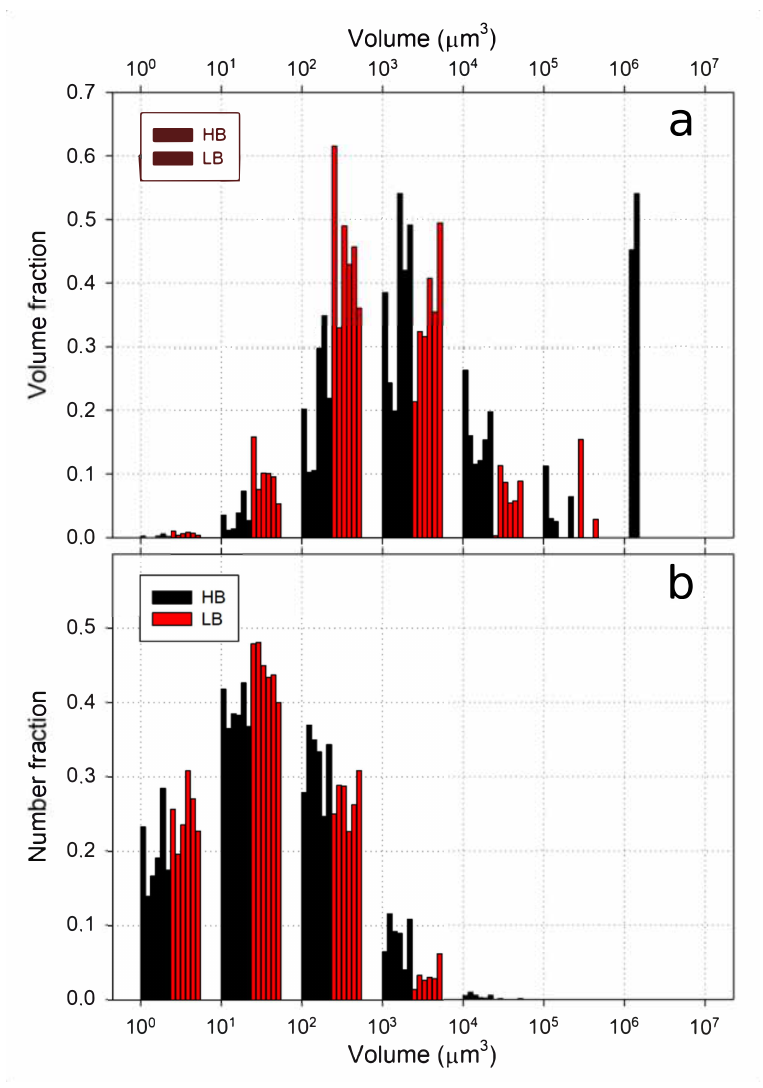
Figure 7. Vesicle size distribution calculated as volume fraction ( a ) and number fraction ( b ) showing the differences between HB and LB portion of the TR samples. For each class, samples represented as a single bar are arranged left to right from TR1 to TR6. The top diagram displays that LB samples have peaks at the lower size (10 2 –10 3 µ m 3 ) with respect to HB samples peaked at 10 3 and 10 6 µ m 3 . The lower diagram does not show any difference in the overall distribution of bubbles number fraction between HB and LB